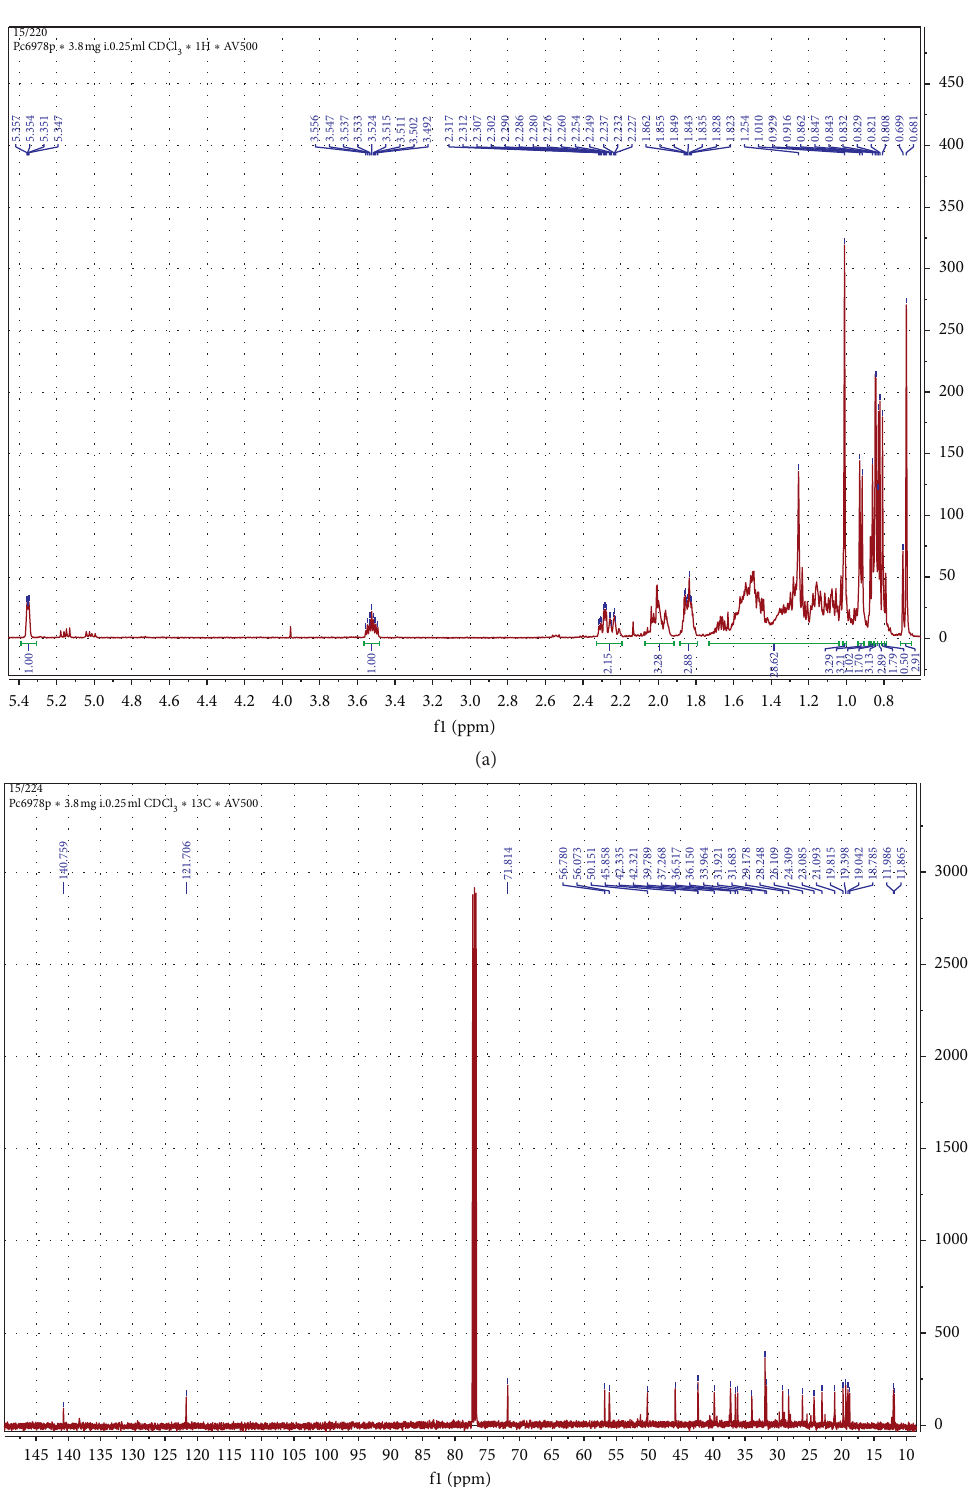
Figure 7: 1 H NMR (CDCl 3 , 500 MHz) spectrum of Pc6978p (a) and